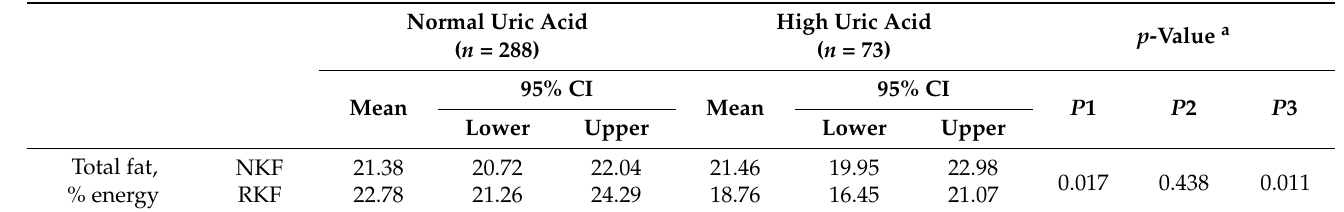
Table 3. Two-way ANCOVA for the two uric acid and two kidney function groups on fat and fatty acid